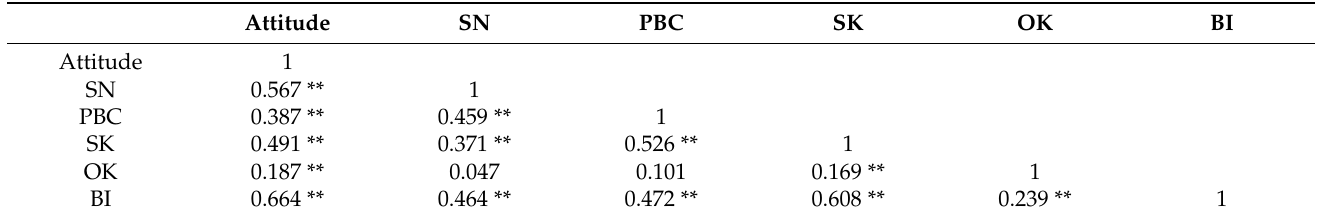
Table 2. Correlations among variables.